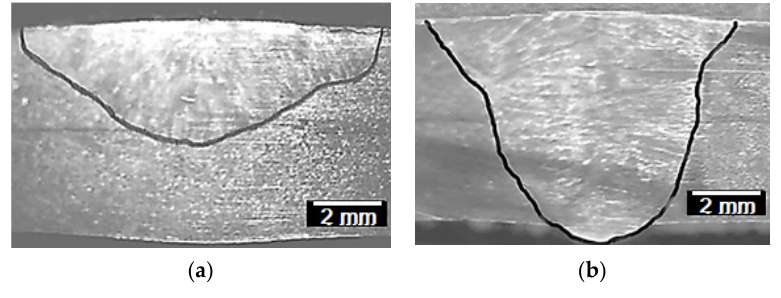
Figure 8. Morphology of TIG ( a ) and ATIG ( b ) welds. Table 10. Weldment bead profiles data of TIG and ATIG. TIG ATIG